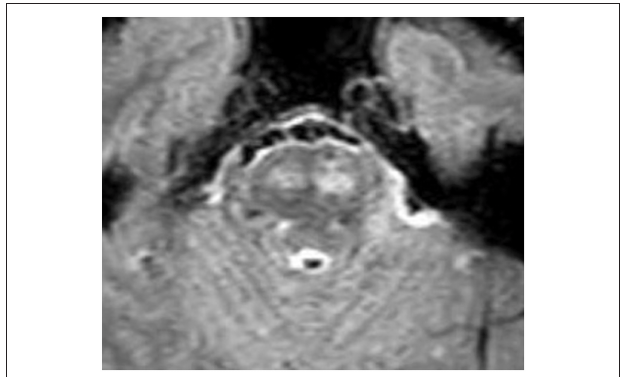
FIGURE 1 | Fluid attenuated inversion recovery (FLAIR) demonstrating pontine hyperintensity from lymphoma involvement.